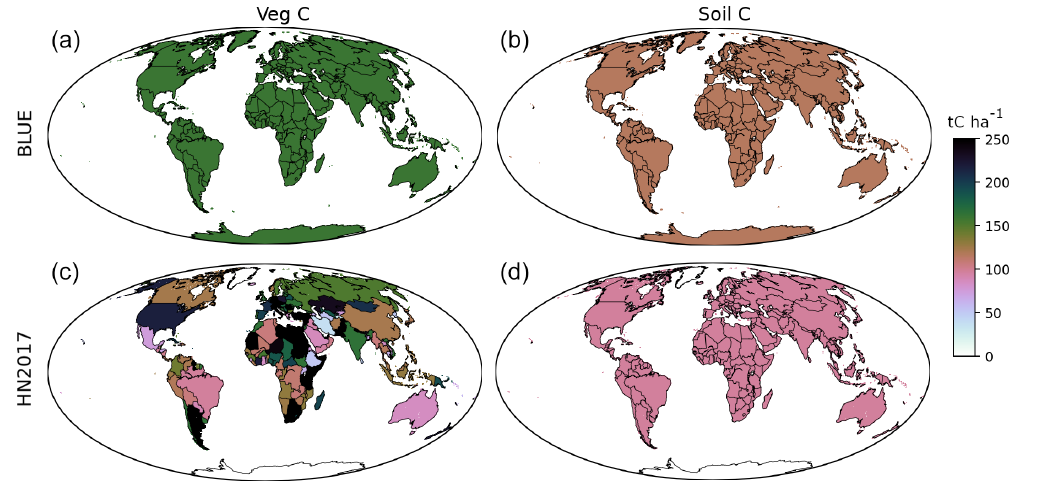
Figure A1. Carbon densities in vegetation (a, c) and soil (b, d) for tropical broadleaved evergreen forests for BLUE (a, b) and HN2017 (c, d) in tCha − 1 . It should be noted that even though C density values are assigned on a per-country basis in HN2017, they do not differ between countries for soil C. Note that C densities are assigned to all countries, even if evergreen broadleaved forest is not present in a given